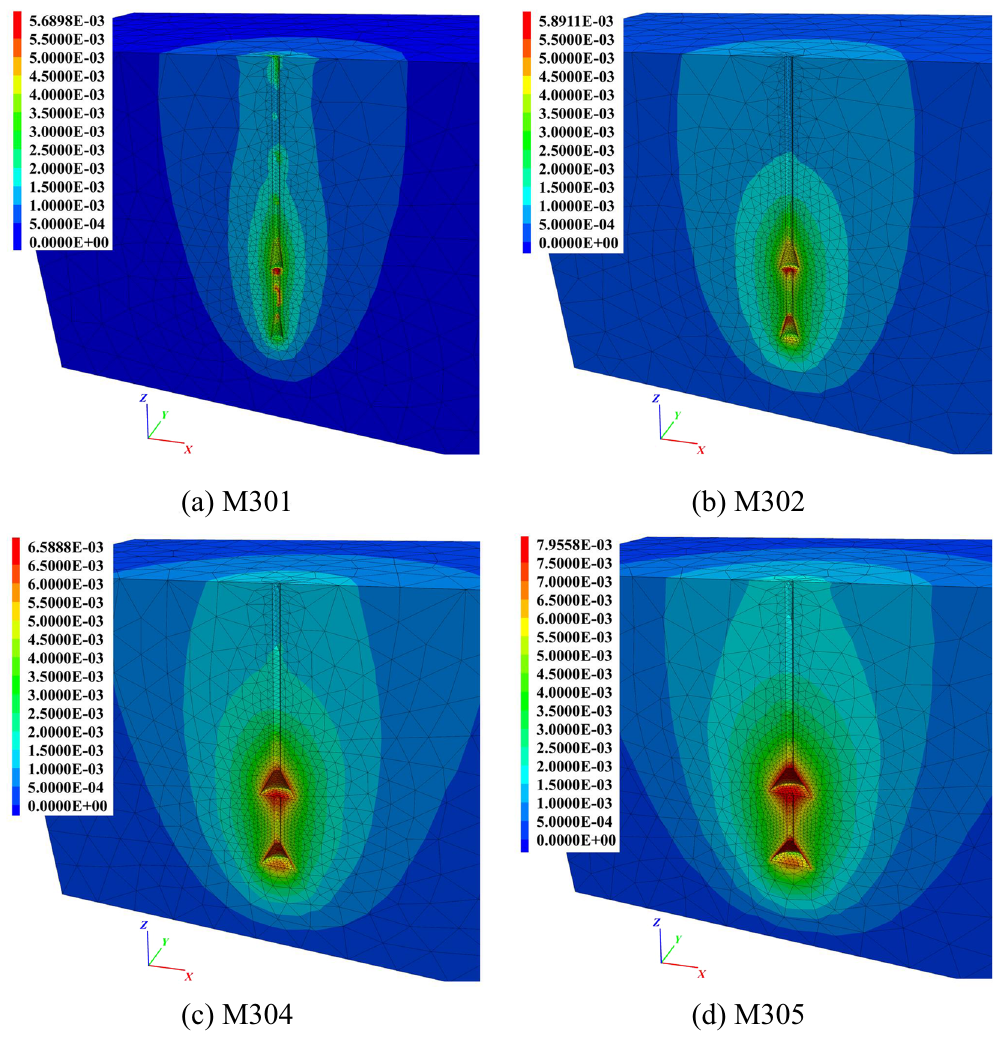
Figure 18. Soil vertical displacement contours of group M3 at 1.0 t . ( a ) M301. ( b ) M302. ( c ) M304. ( d ) M305.